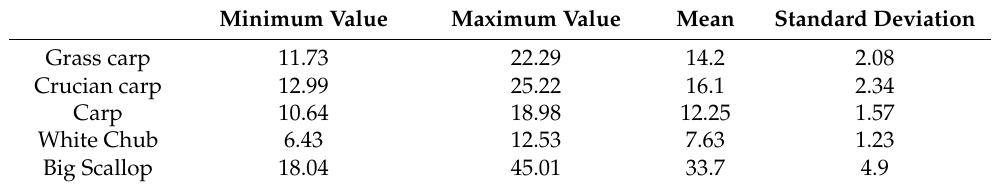
Table 1. Descriptive statistics of the data set.